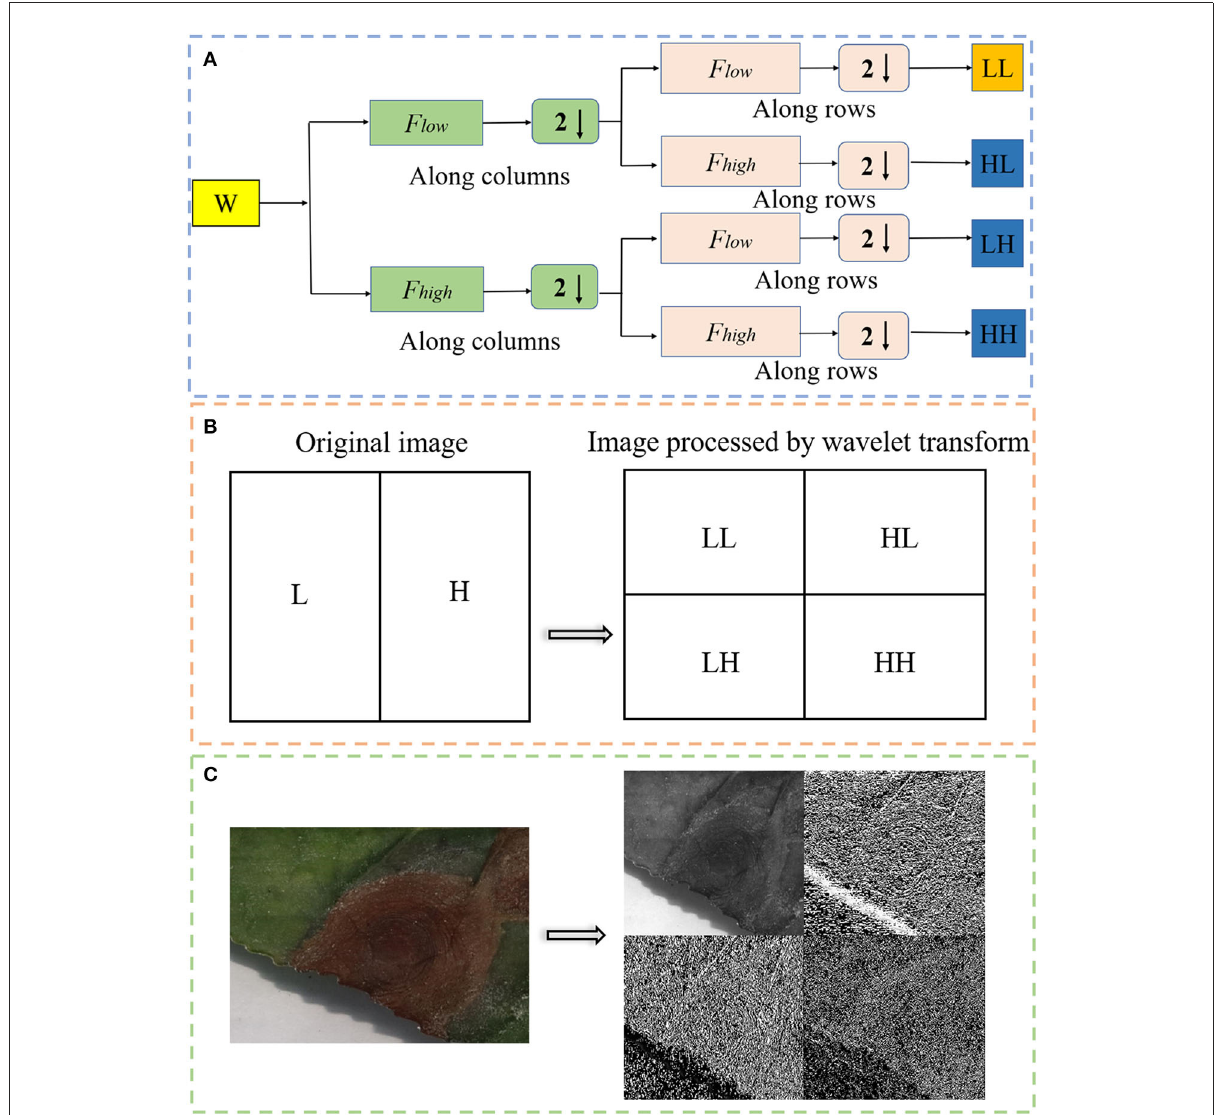
FIGURE5 (A) The image signal is separated by wavelet transform according to low frequency and high frequency. “W” is the original image; “ F high ” is the high frequency component; “ F low ” is the low frequency component; (B) schematic diagram of wavelet transform; and (C) real image of wavelet